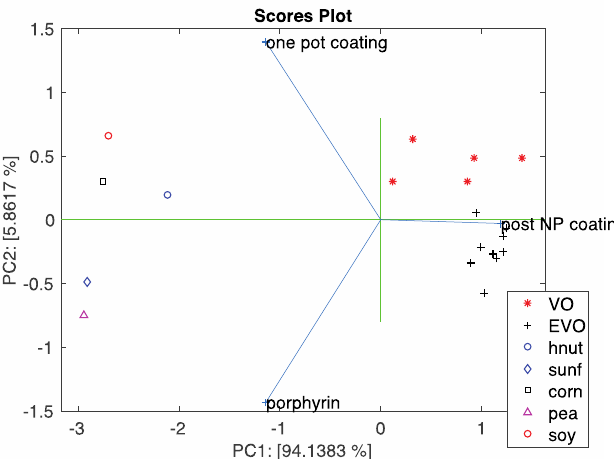
Figure 8. Plot of the scores and loadings of the first and second principal components of the vegetable oils experiment. Axis labels report the explained variance. Samples legend: VO: virgin olive oil; EVO: extra-virgin olive oil; hnut: hazelnut oil, sunf: sunflower oil; corn: corn oil; pea: peanut oil; soy: soybean oil.